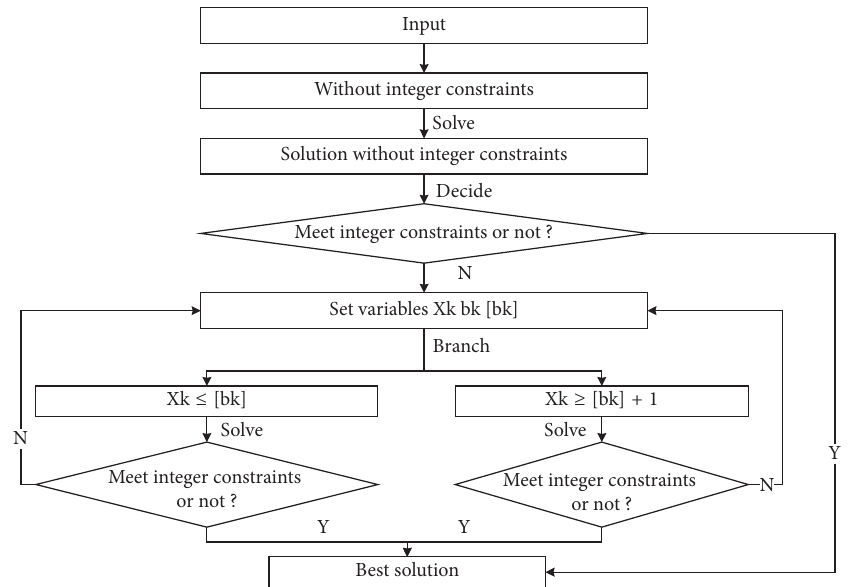
Figure 2: Solution process of branch and bound